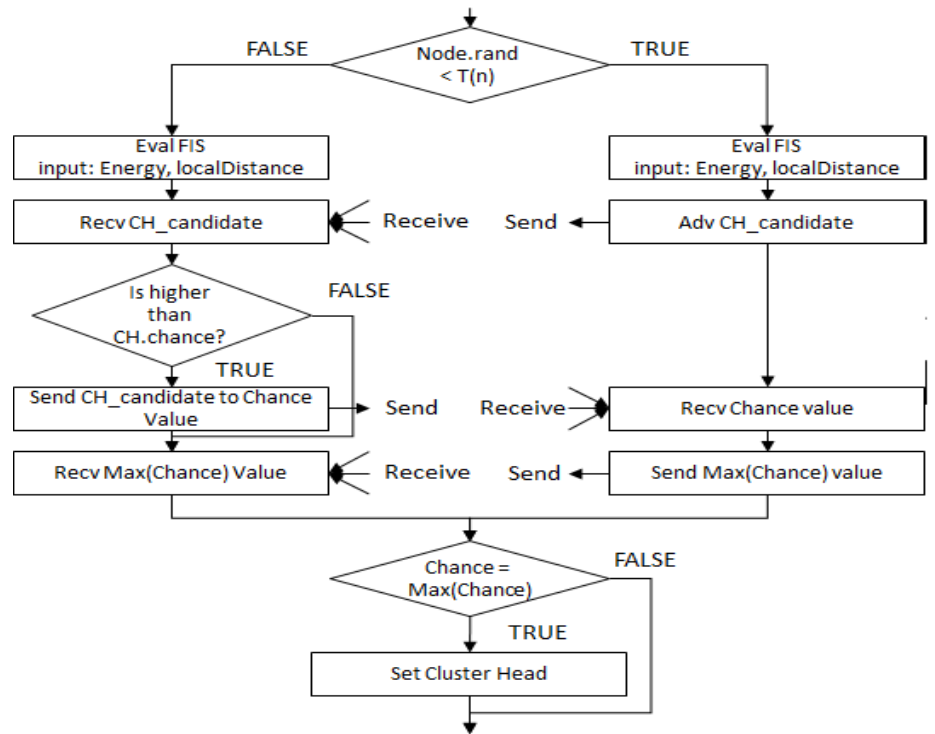
Figure 7. Flowchart of the cluster head selection process.